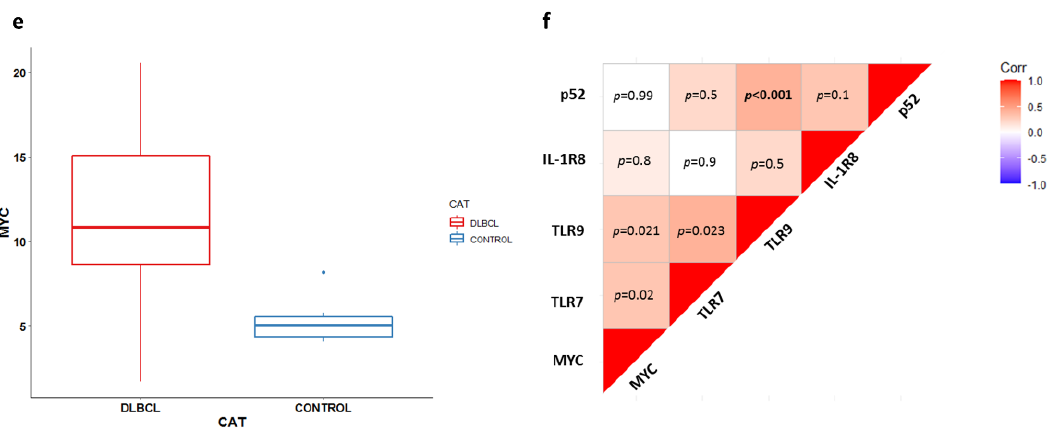
Figure 1. Gene expression results and correlations between target genes. ( a – e ) Real-time PCR results of IL-1R8 ( a ), p52 ( b ), TLR7 ( c ), TLR9 ( d ), and MYC ( e ) in 50 cDLBCLs and 12 control lymph nodes; CAT = category. ( f ) Correlation matrix showing statistical correlations between target gene expressions. Correlation coefficients were calculated using the Spearman method.